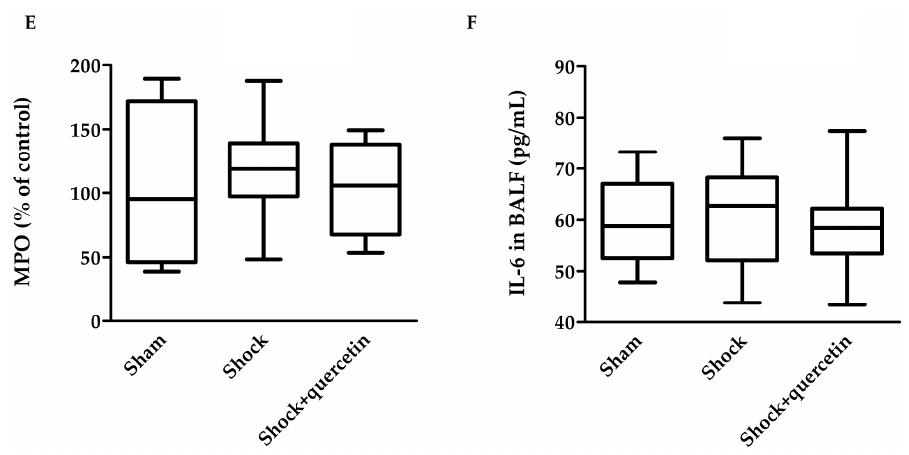
Figure 5. Markers of inflammation and vascular permeability: ( A ) Edema (wet to dry weight ratio); ( B ) proteins in Bronchoalveolar Lavage Fluid (BALF); ( C ) IgM BALF/plasma ratio ( D ) cells in BALF; ( E ) Myeloperoxidase (MPO) activity and ( F ) IL-6 in BALF measured at the end of reperfusion. Box-and-whisker plot showing medians with interquartile range and minimum and maximum values in each group. * p < 0.05, ** p < 0.01 and *** p < 0.005 vs. sham group.